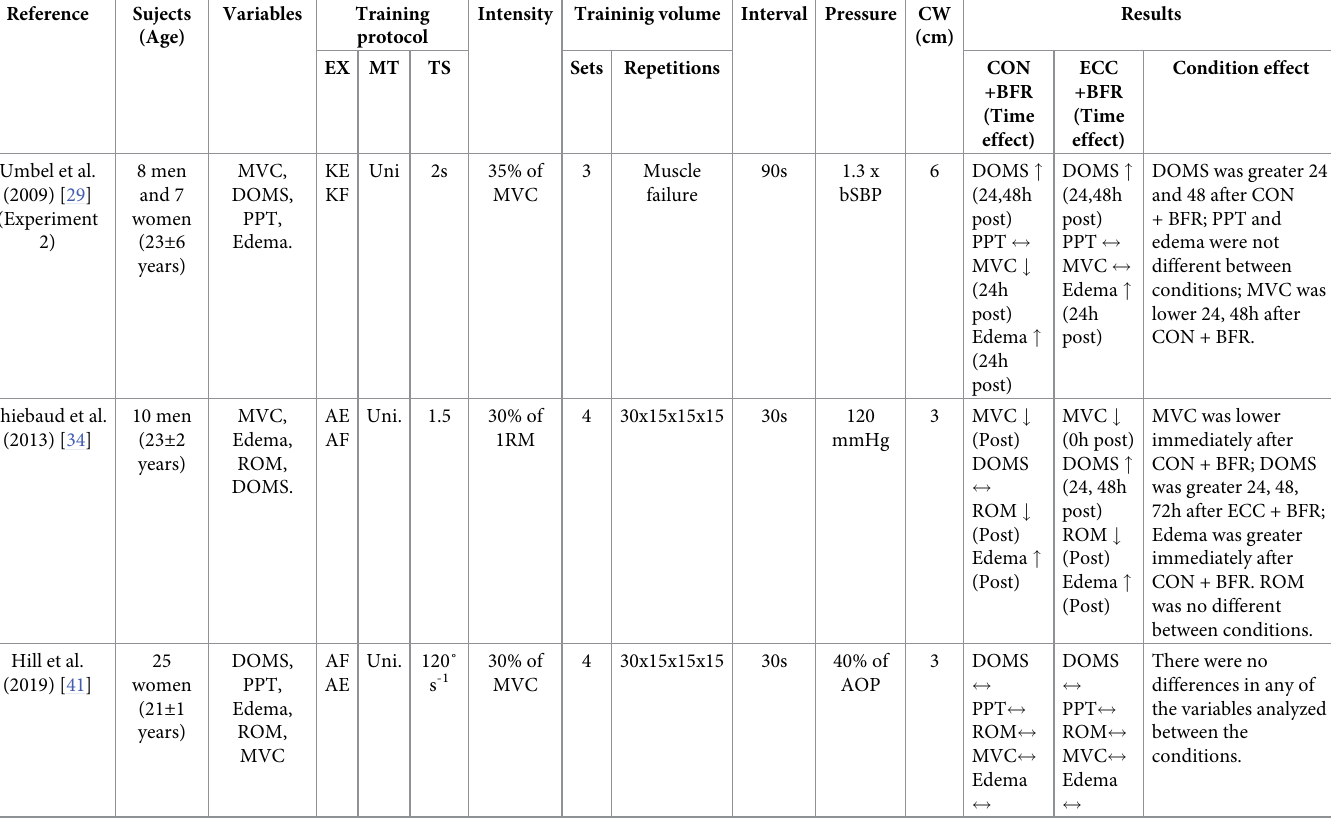
Table 4. Characteristics of studies that compared muscle damage between eccentric and concentric actions of low-load resistance exercise with blood flow